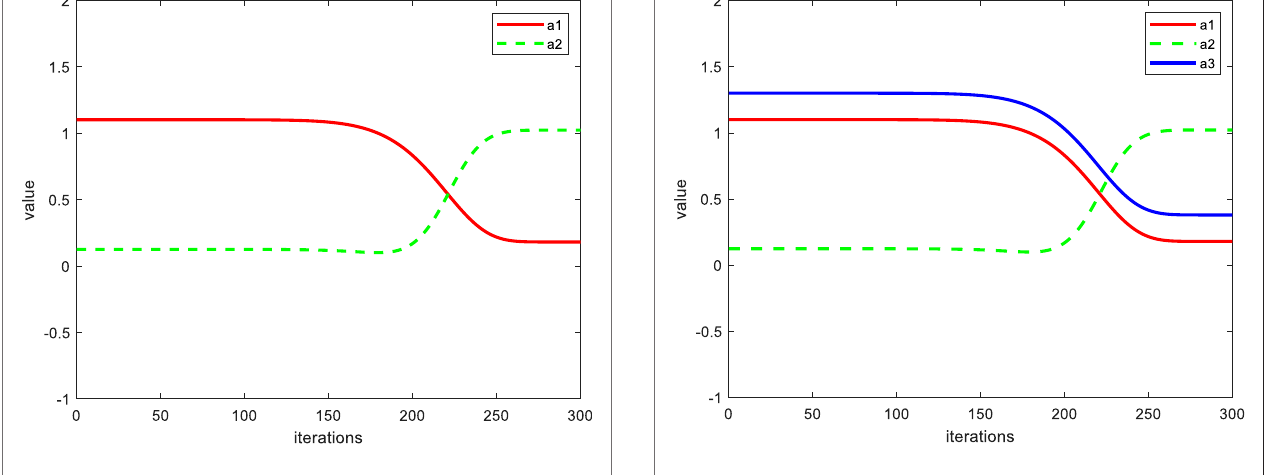
FIGURE 1 | Relationship between α 1 and α 2 . FIGURE 2 | Relationship between α 1 , α 2 , and α 3